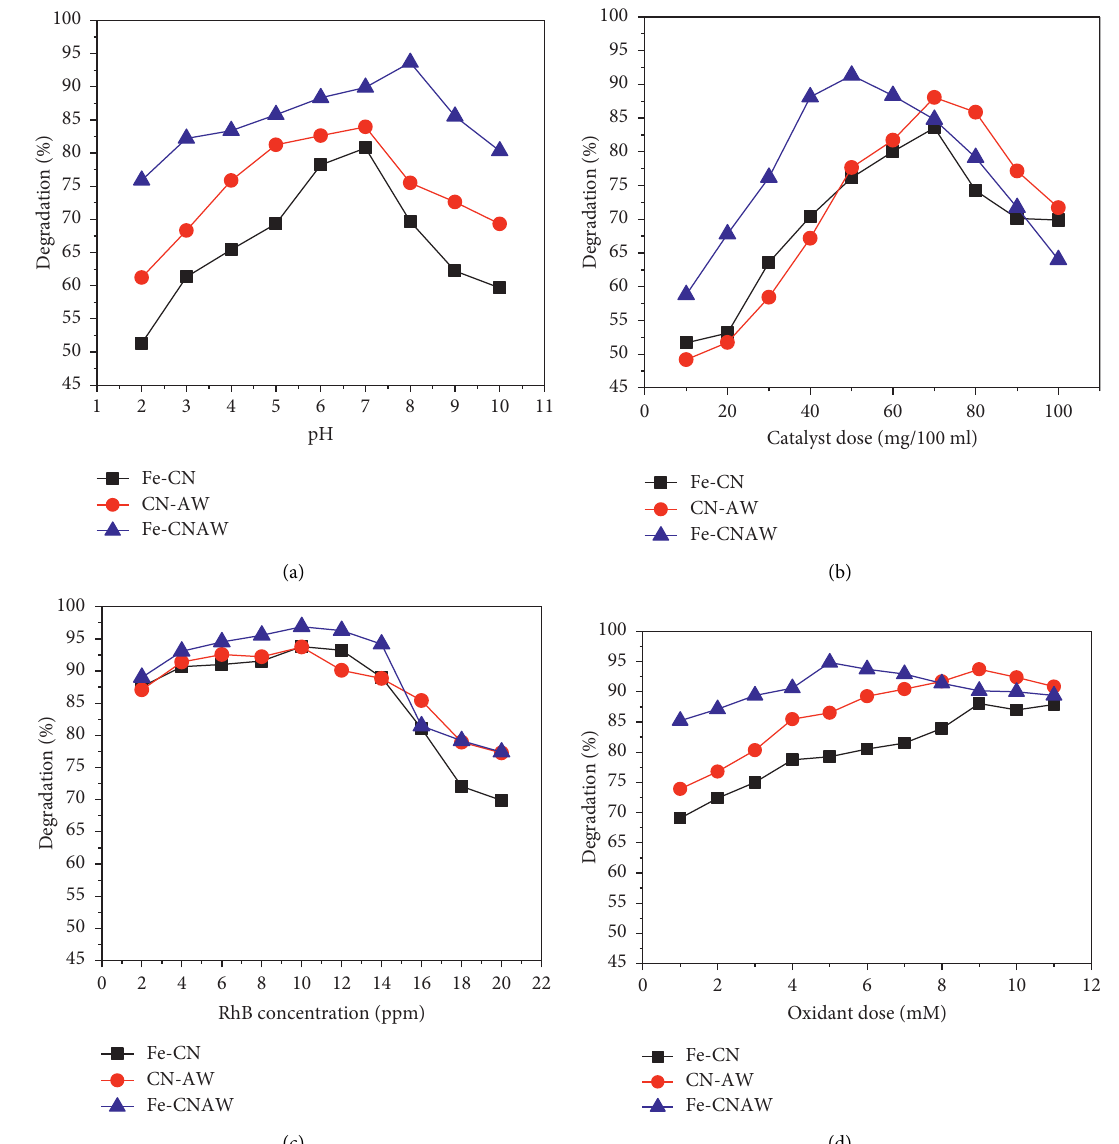
Figure 7: Optimization of reaction parameters using Fe-CN, CN-AW, and Fe-CN-AW: (a) pH, (b) photocatalyst dose, (c) RhB Initial concentration, and (d) oxidant